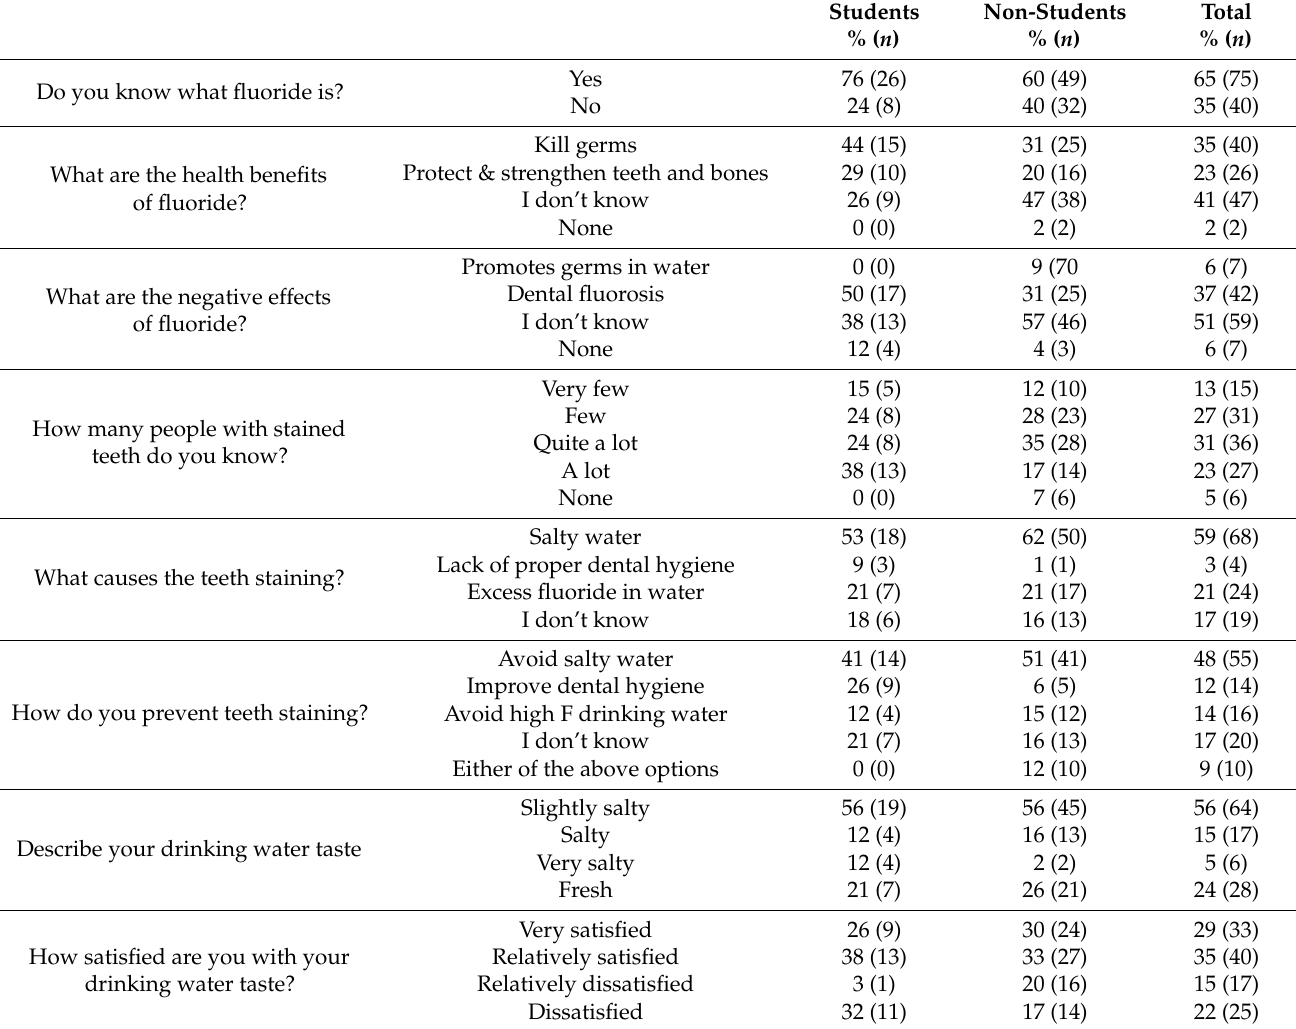
Table 1. Public perception on the benefits, effects, and preventive measures linked to F − content and salinity in drinking water in the Makueni County.